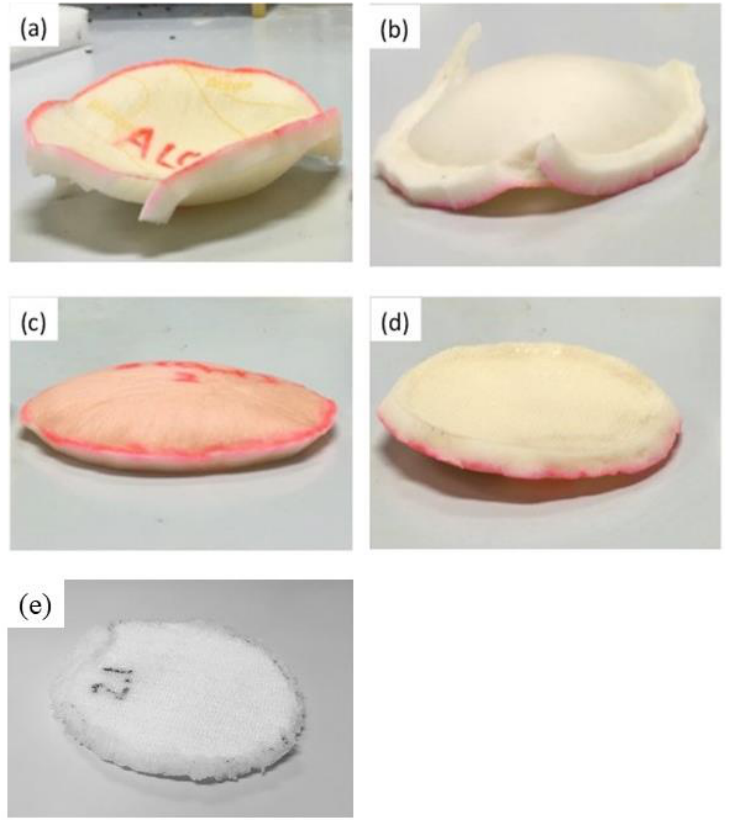
Figure 7. Shape changes of the foam dressings and spacer fabric after absorbing water: ( a ) the outer surface of Foam A; ( b ) the wound contact layer of Foam A; ( c ) the outer surface of Foam B; ( d ) the wound contact layer of Foam B, and ( e ) the superabsorbent spacer fabric.